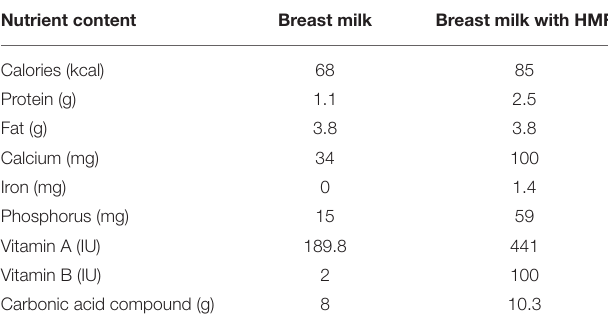
TABLE 1 | The main nutrients of the two milk formulas (per